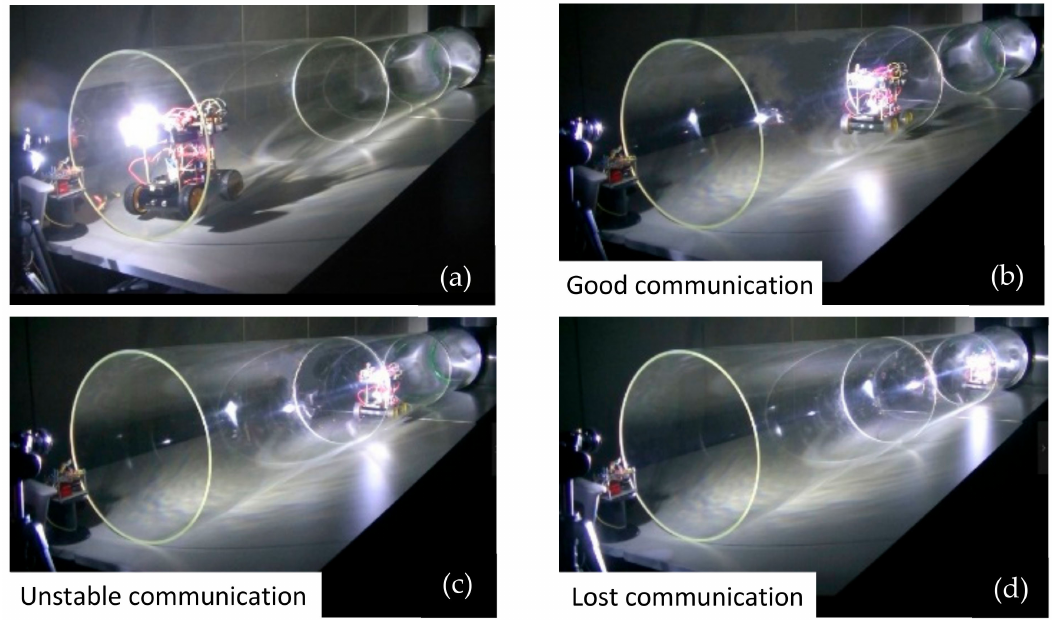
Figure 13. Movement test with one leader